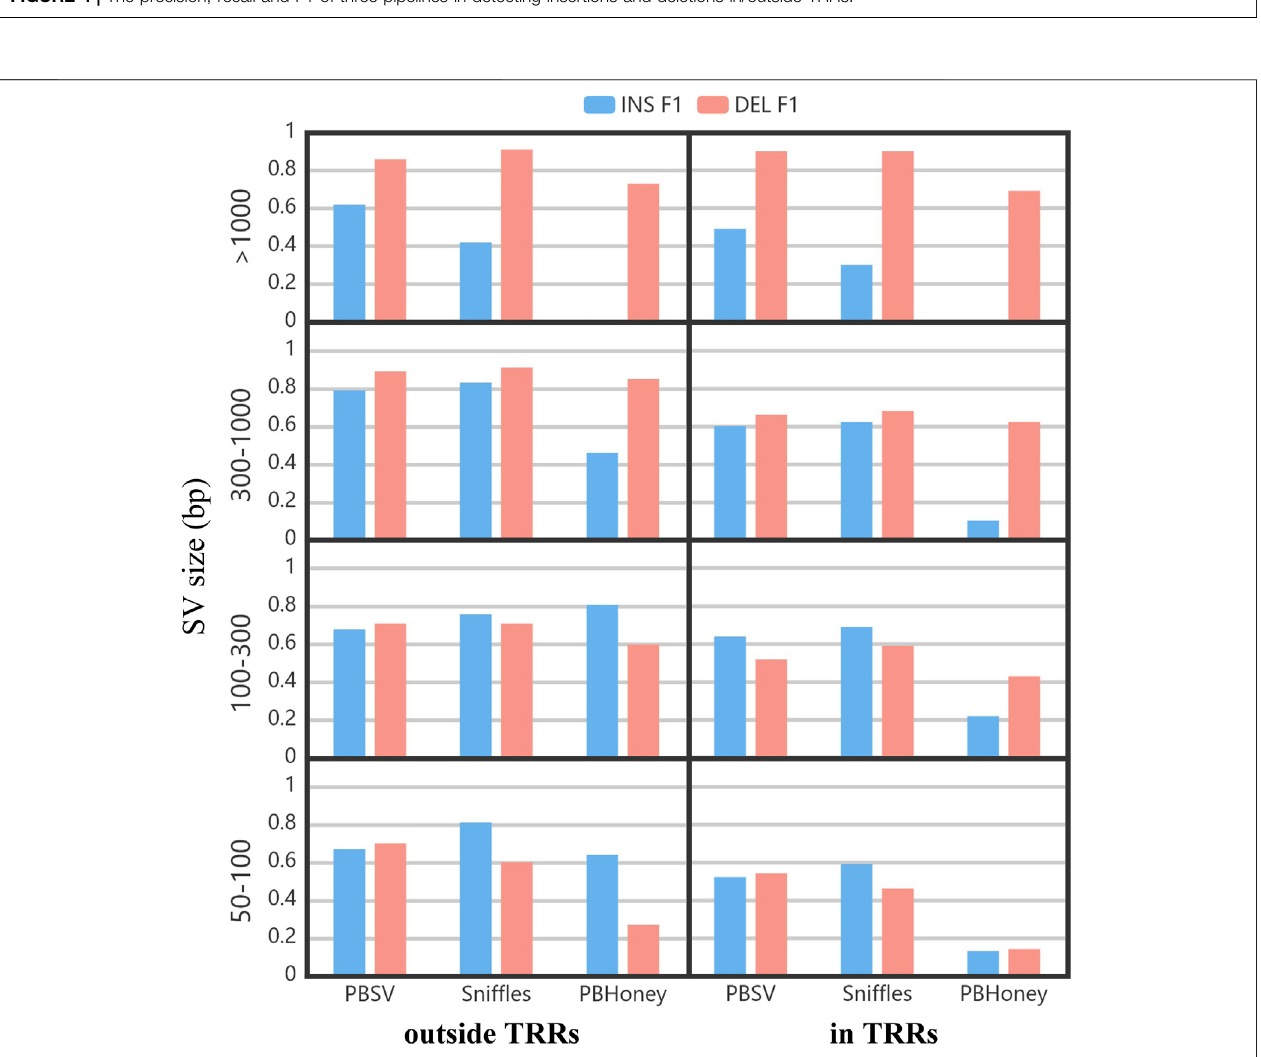
FIGURE 5 | The F1 of insertions and deletions divided by the size and the location relation with TRRs of SVs. The size ranges included 50 – 100 bp, 100 – 300 bp, 300 – 1,000 bp and > 1,000 bp.